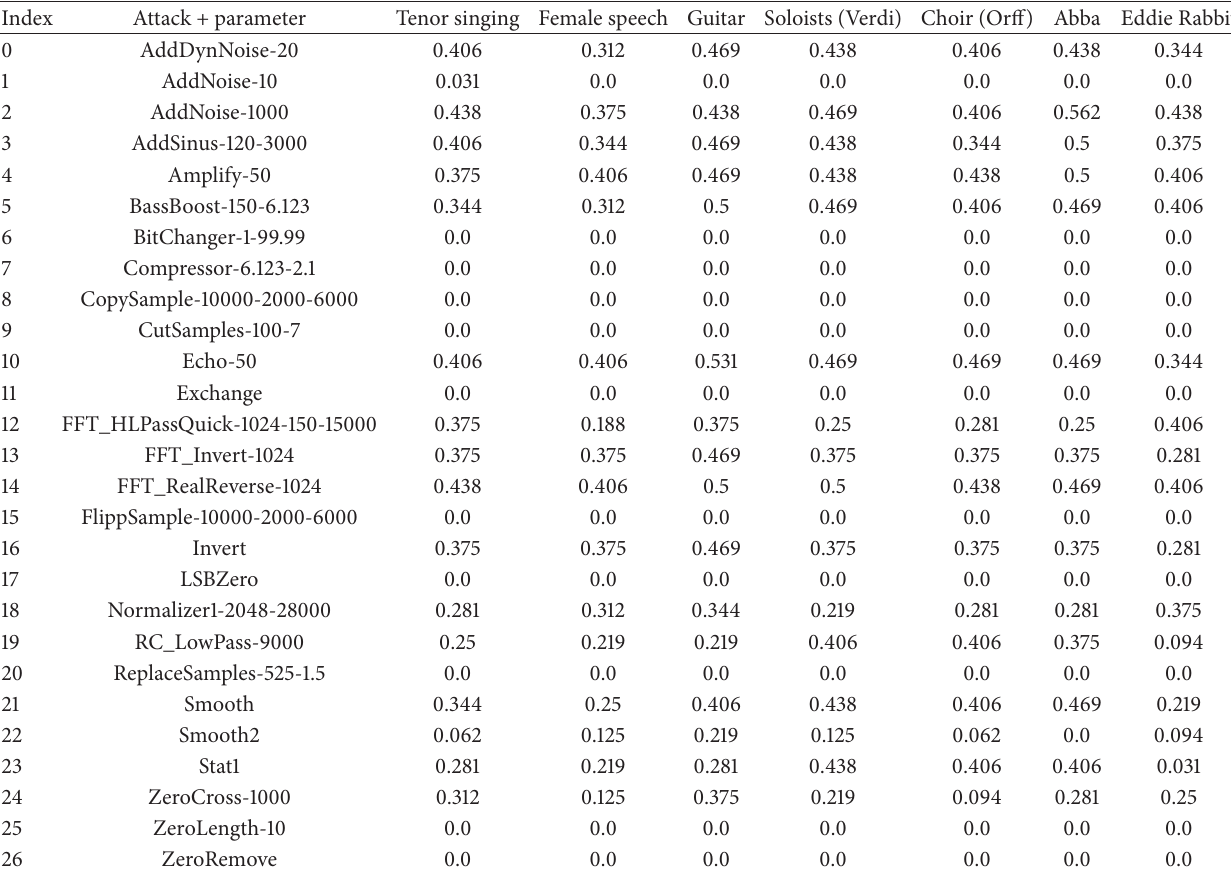
Table 1: Bit error rates of extracted 32 bit watermarks after various StirMark attacks on seven example audio files. Parameters used are